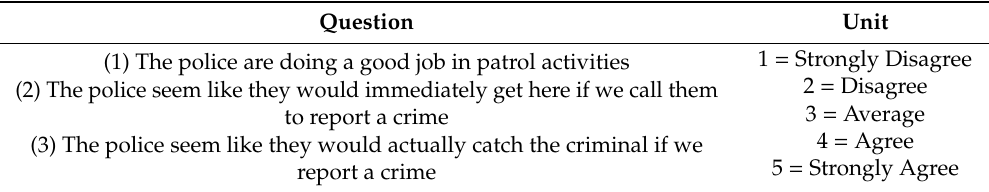
Table 1. Questions on perception of neighborhood